Question: Condense the content of this figure into a single sentence.
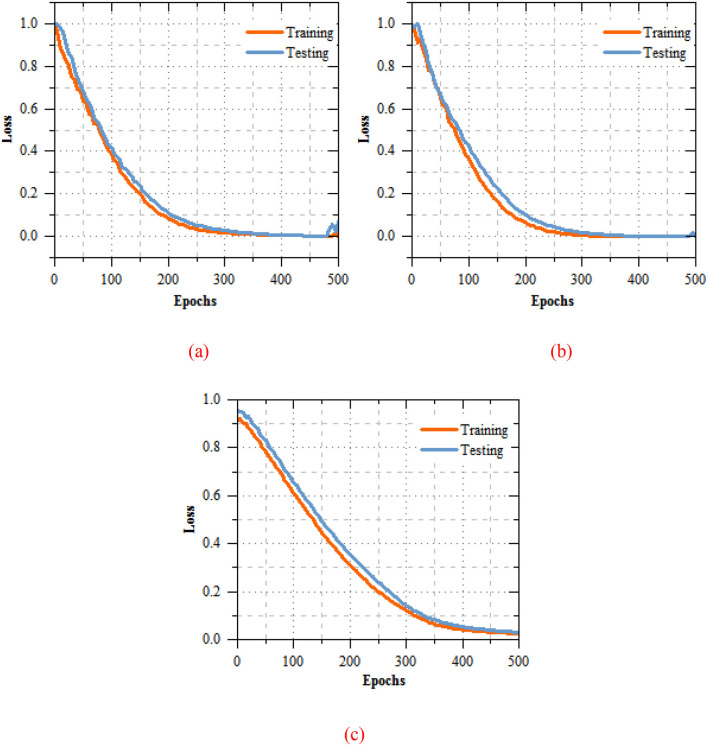
Answer: Loss performance of the LCNN model on breast cancer detection using (a) MIAS, (b) BreakHis, and (c) multimodal datasets.